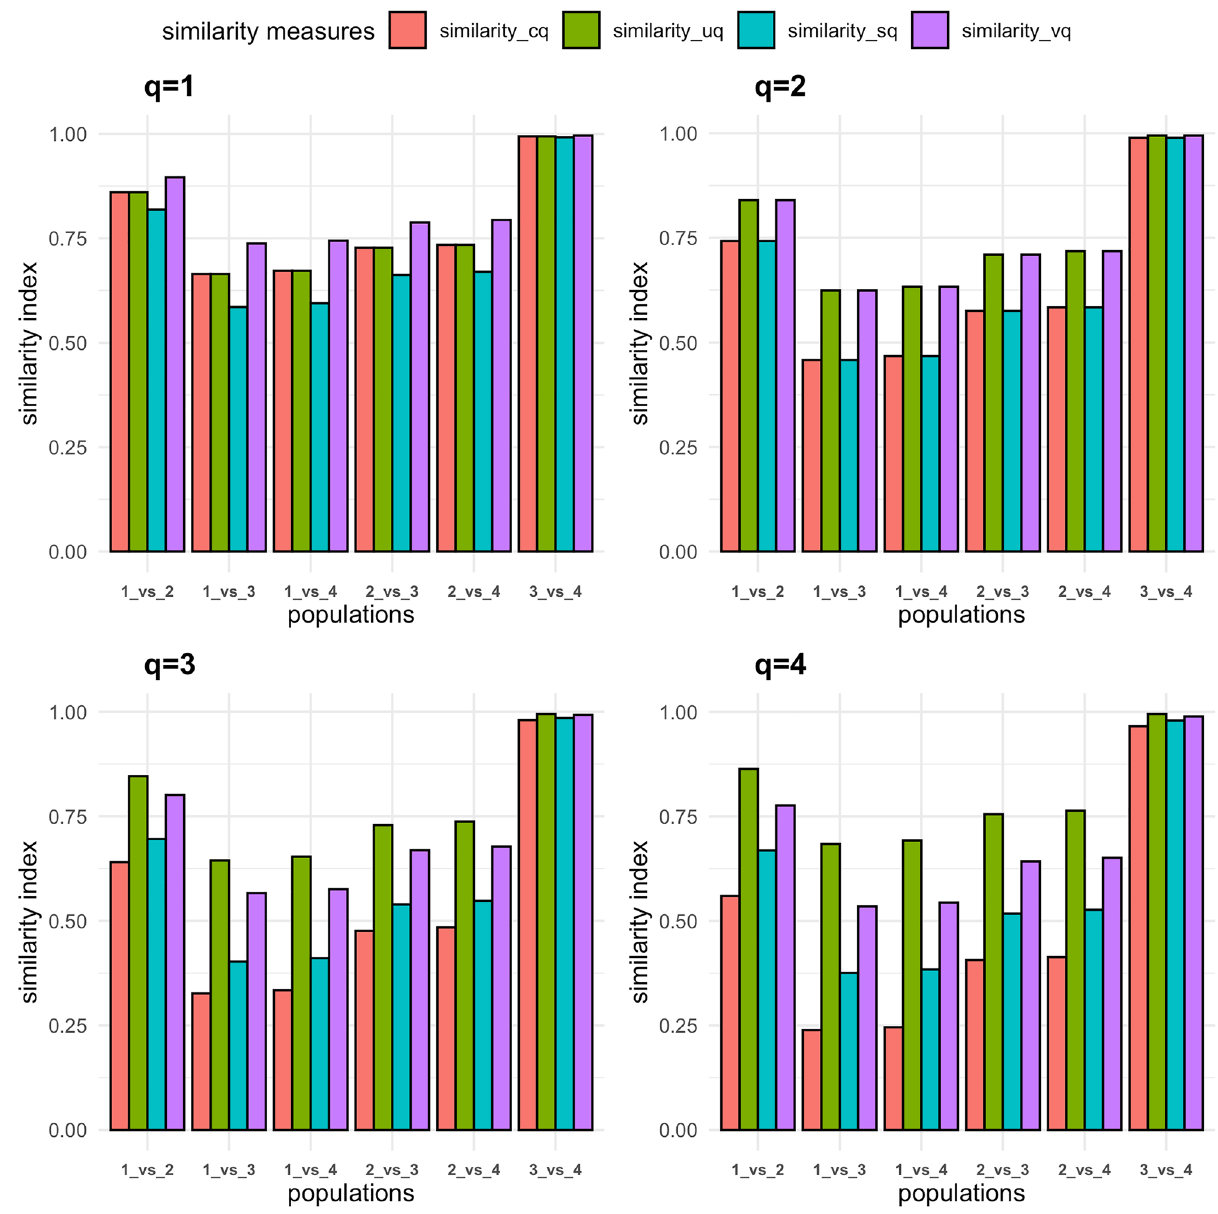
Figure 5. Average autosomal similarity indices at diversity orders q = 1–4. Populations: (1) Arabian Peninsula dromedary camels; (2) dromedary camels from Iran; (3) Bactrian camels from Iran; and (4) Bactrian camels from